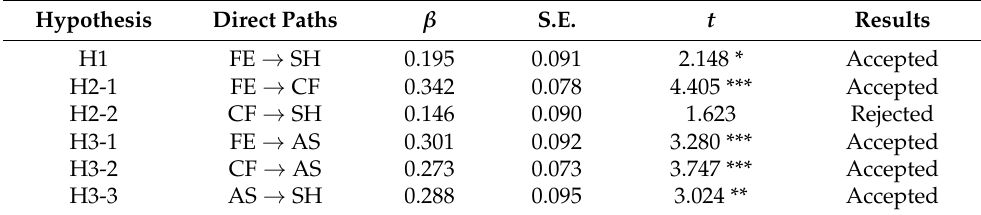
Table 3. Results of direct path coefficient verification.